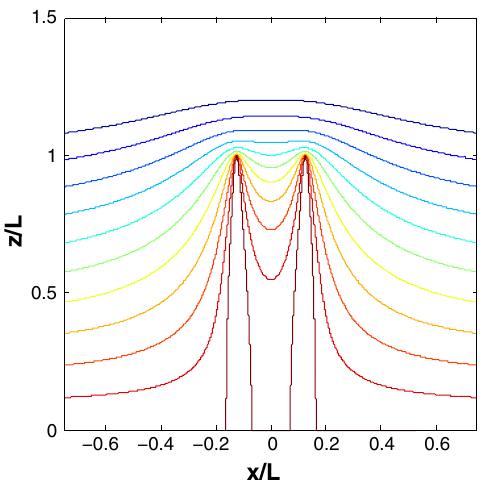
FIG. 20. Contour lines associated with an analytical model representing the carbon fibers of Fig. 1. L is approximately the length of the fiber if the apex radius is small compared to the width of the fiber. The apex radius in the analytical model has been blunted to allow for easier visualization.